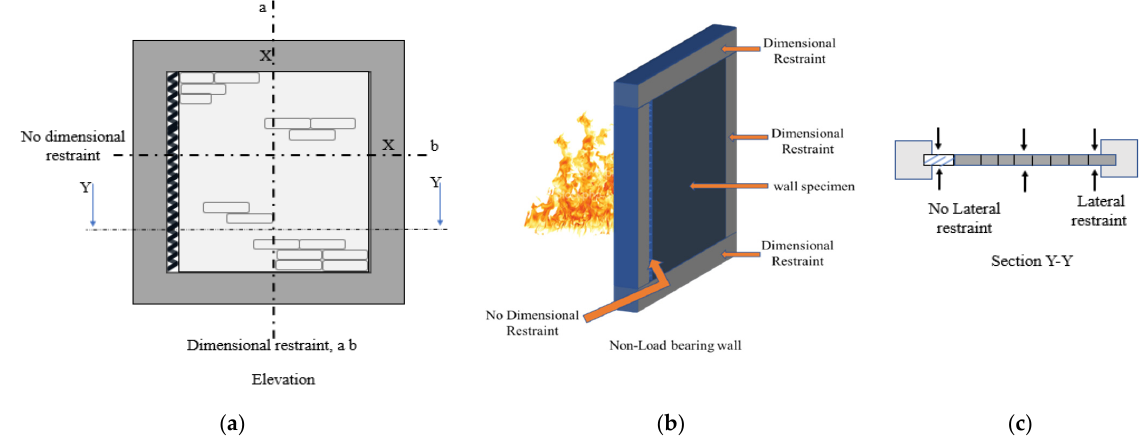
Figure 6. Restraints for non ‐ load ‐ bearing walls: ( a ) 2D, ( b ) 3D, and ( c ) section.